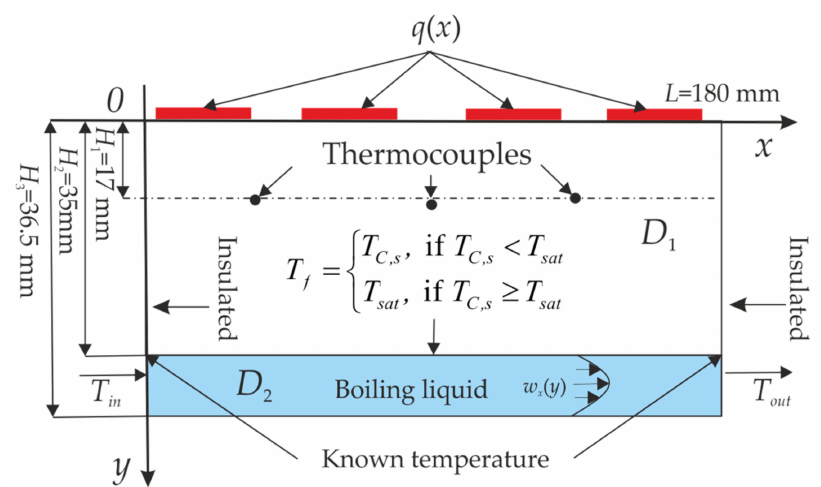
Figure 10. Scheme of the experimental stand with the adopted boundary conditions; (pictorial view, not to